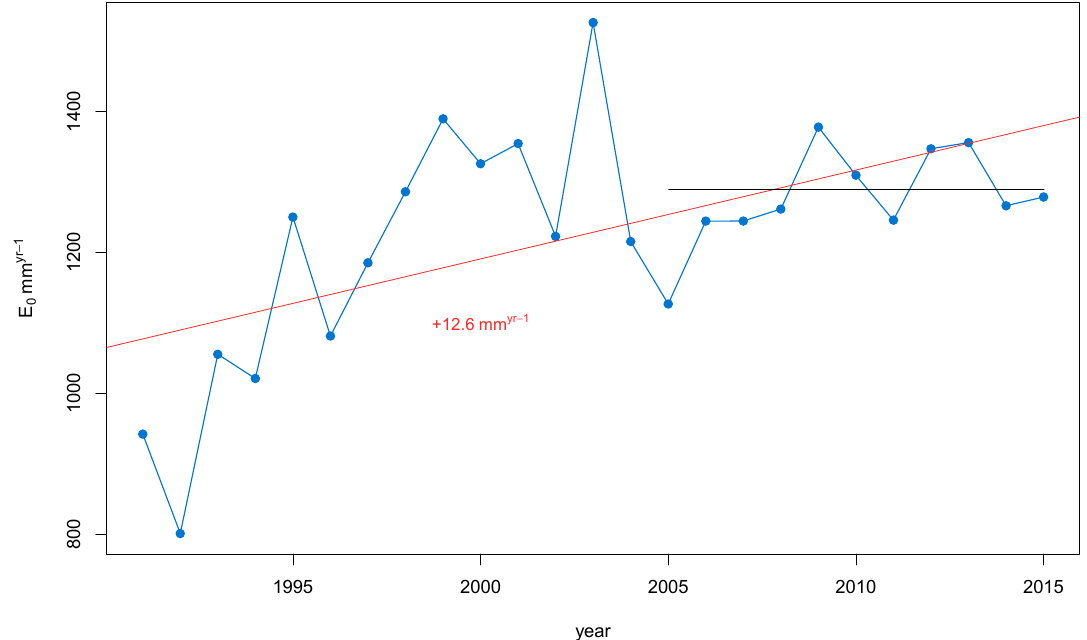
Figure 8. Evolution of the yearly sums of the observed evaporation in Palma (Mallorca) over the period 1991–2015. The trend lines (linear regressions) are fitted to the 1991–2015 (red) and the 2006–2015 sub-period (black) observed E 0 data, respectively.